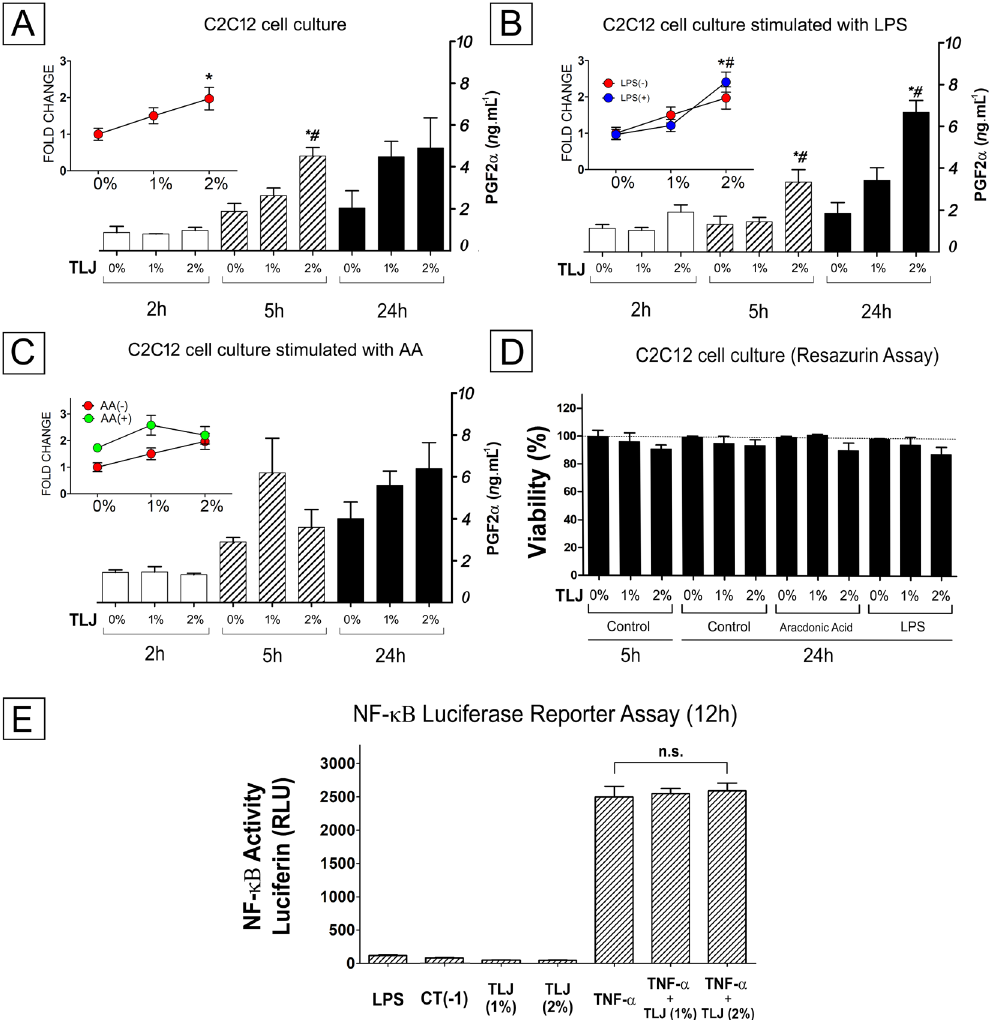
Figure 3. Demonstration of the augmentation of the production of PGF2 α by C2C12 cells treated with TLJ without association with lost of cell viability or NF-k β activity induction. The productions of PGF2 α by the C2C12 cell line treated with different concentration of buffered TLJ (1% or 2%; pH.7.0) and exposed or not ( A ) to 10 ng of LPS ( B ) or 10 µ M of Arachidonic Acid ( C ) at different time intervals (2, 5 or 24 h),were quantified by ELISA. Line graph ( A ) shows the variation of the production of PGF2 α (fold change) induced by different concentrations of TLJ (n = 9; * p < 0.05 in relation to the 0% Control) and bar graph shows the dynamic of the production of PGF2 α (ng.mL − 1 ) induced by TLJ (n = 3) at different times ( * # p < 0.05 in relation to the 1% and 0% Controls). Line graph ( B ) shows the parity in the production of PGF2 α (fold change)by cells treated by TLJ (n = 9) and stimulated or not with LPS. Bar graph shows the dynamic of the production of PGF2 α (ng. mL − 1 ) induced by LPS and TLJ (n = 3) treatments at different times ( * # p < 0.01 in relation to the 1% and 0% Controls). Line graph ( C ) shows the difference in the production of PGF2 α (fold change) after stimulation with arachidonic acid (AA) and treatment with TLJ (n = 9; p < 0.05) in relation to the AA( − ). The bar graph ( C ) shows the change of the production of PGF2 α induced by TLJ (n = 3) at different times after AA stimulation. Bar graph ( D ) shows the results of the viability of the C2C12 cell line (n = 4) after 5 h or 24 h of exposition to diverse concentrations (0, 1 and 2%) of buffered TLJ quantified by resazurin assay. Bar graph ( E ) showing the activity of the NF −κβ reporter from HEK293 cells (n = 5) treated only with buffered TLJ (1 or 2%) or stimulated with TNF- α and TLJ for 12 h, in comparison with Controls group (CT-; TNF- α : 10 ng/mL and LPS: 10 ug/mL). NS: non-significant. In all the analyses, the results were represented by mean ± SEM and the ANOVA and Newman-Keuls Multiple Comparison statistic tests were